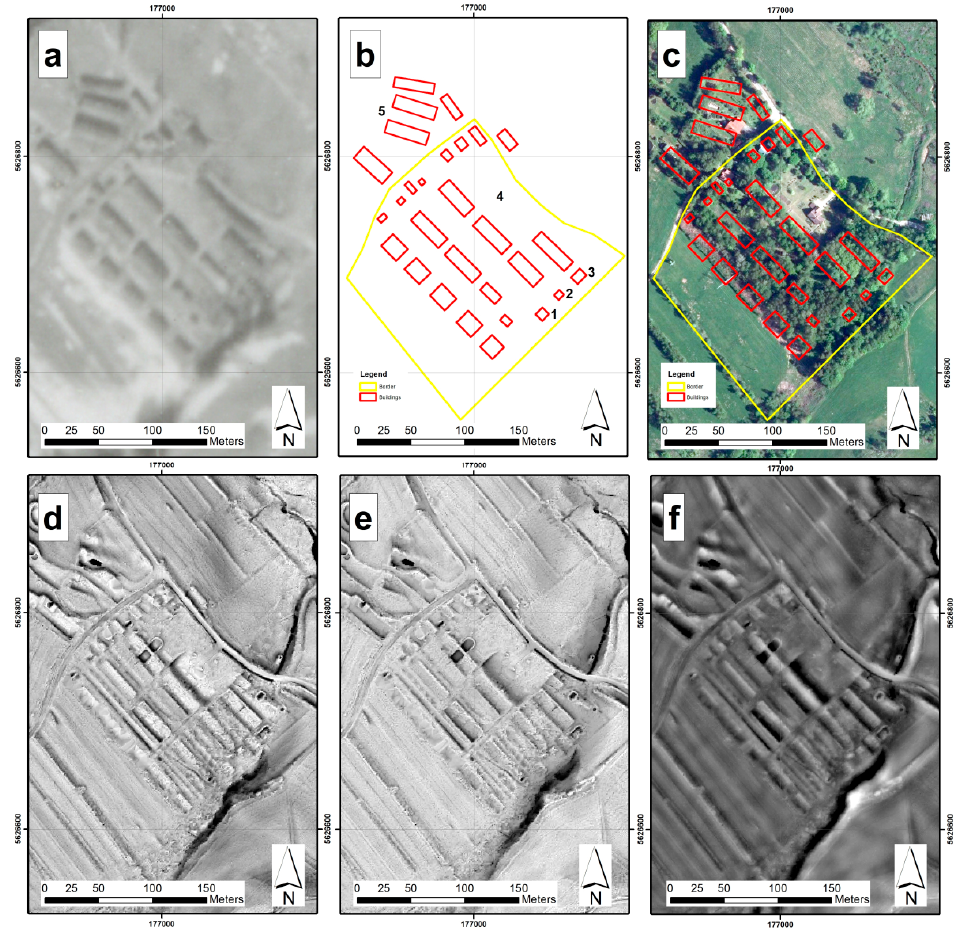
Figure 3. Labour camp AL Wolfsberg: ( a ) Aerial photo taken in February 1945 (© NARA), ( b ) reconstruction of camp based on ’45 photo: 1 – bath, 2 – kitchen, 3 – water tank, 4 – assembly ground, 5 – barracks of the camp HQ and the staff, ( c ) recent orthophoto of camp area with outlined camp plan (© Head Office of Geodesy and Cartography in Poland), ( d ) SVF image (radius 5m), ( e ) Openness positive image (radius 10m), ( f ) Local Dominance image (min./max.: 10m – 10m). Coordinate grid: UTM Zone 34 N (EPSG: 32634).